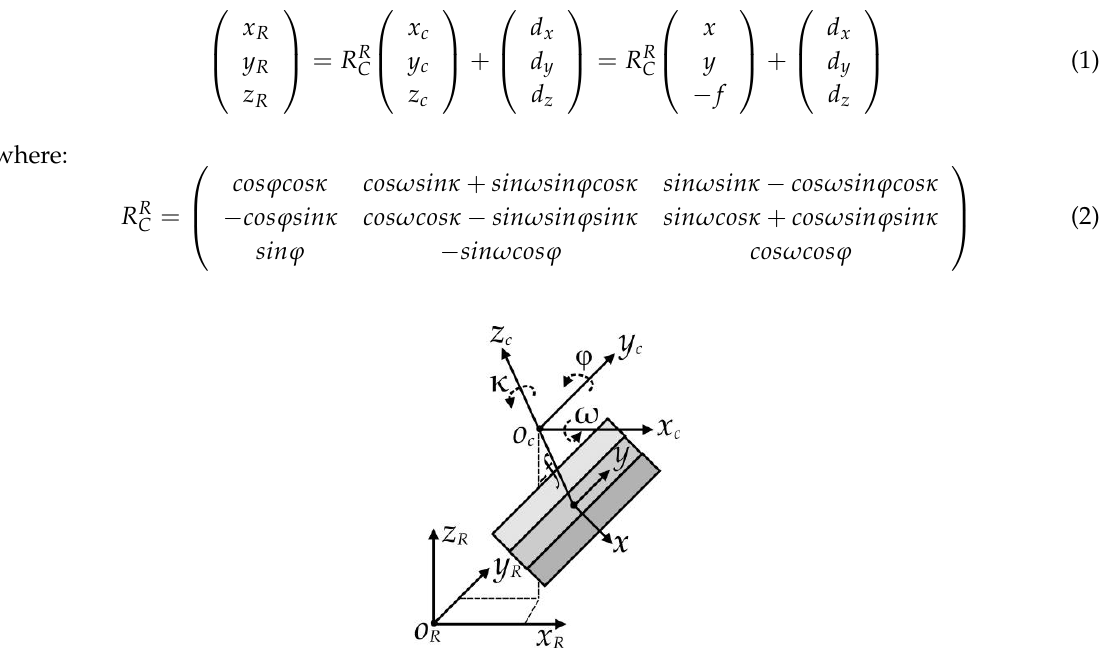
Figure 3. From image coordinate to image reference coordinate system.